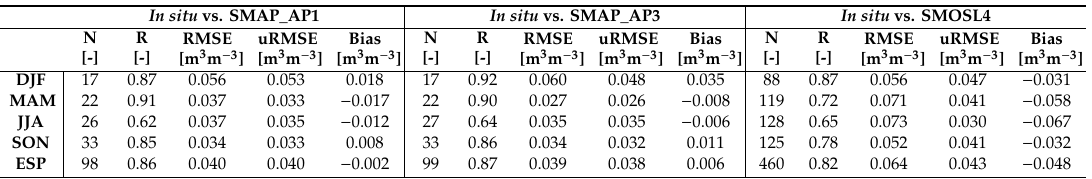
Table 6. Statistics obtained from the comparison of in situ SSM against the high-resolution pixel SSM of SMAP_AP1 at 1 km (left), SMAP_AP3 at 3 km (center) and SMOSL4 at 1 km (right) from